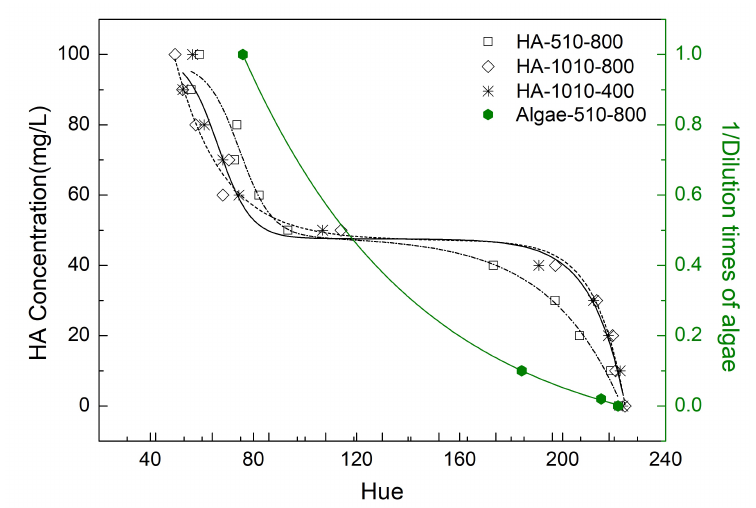
Figure 7. The hue angle of pure humic acid (in black) and algae extraction (in green) at different con-